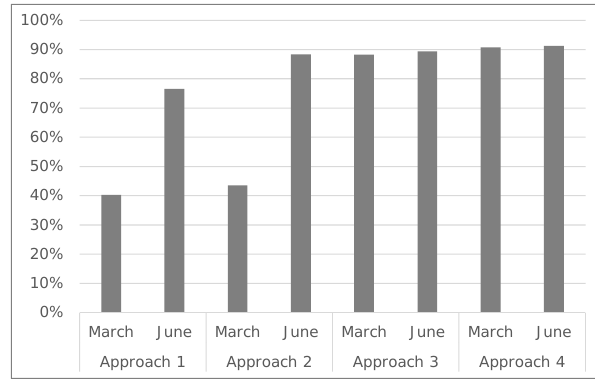
Figure 5. Overall accuracy summary of all approaches.